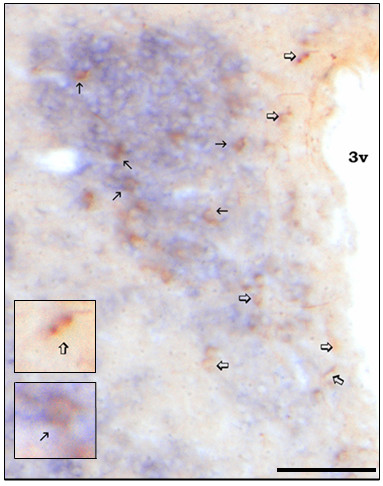
Colocalization of FTO and oxytocin. Oxytocin (brown cells) and FTO mRNA (blue cells) detected in the coronal section containing the PVN. Thin arrows, neurons expressing oxytocin and FTO; Open arrows, oxytocin cells devoid of FTO. Scale bar: 0.25 mm. Inserts: three-fold higher magnification of PVN neurons of interest.